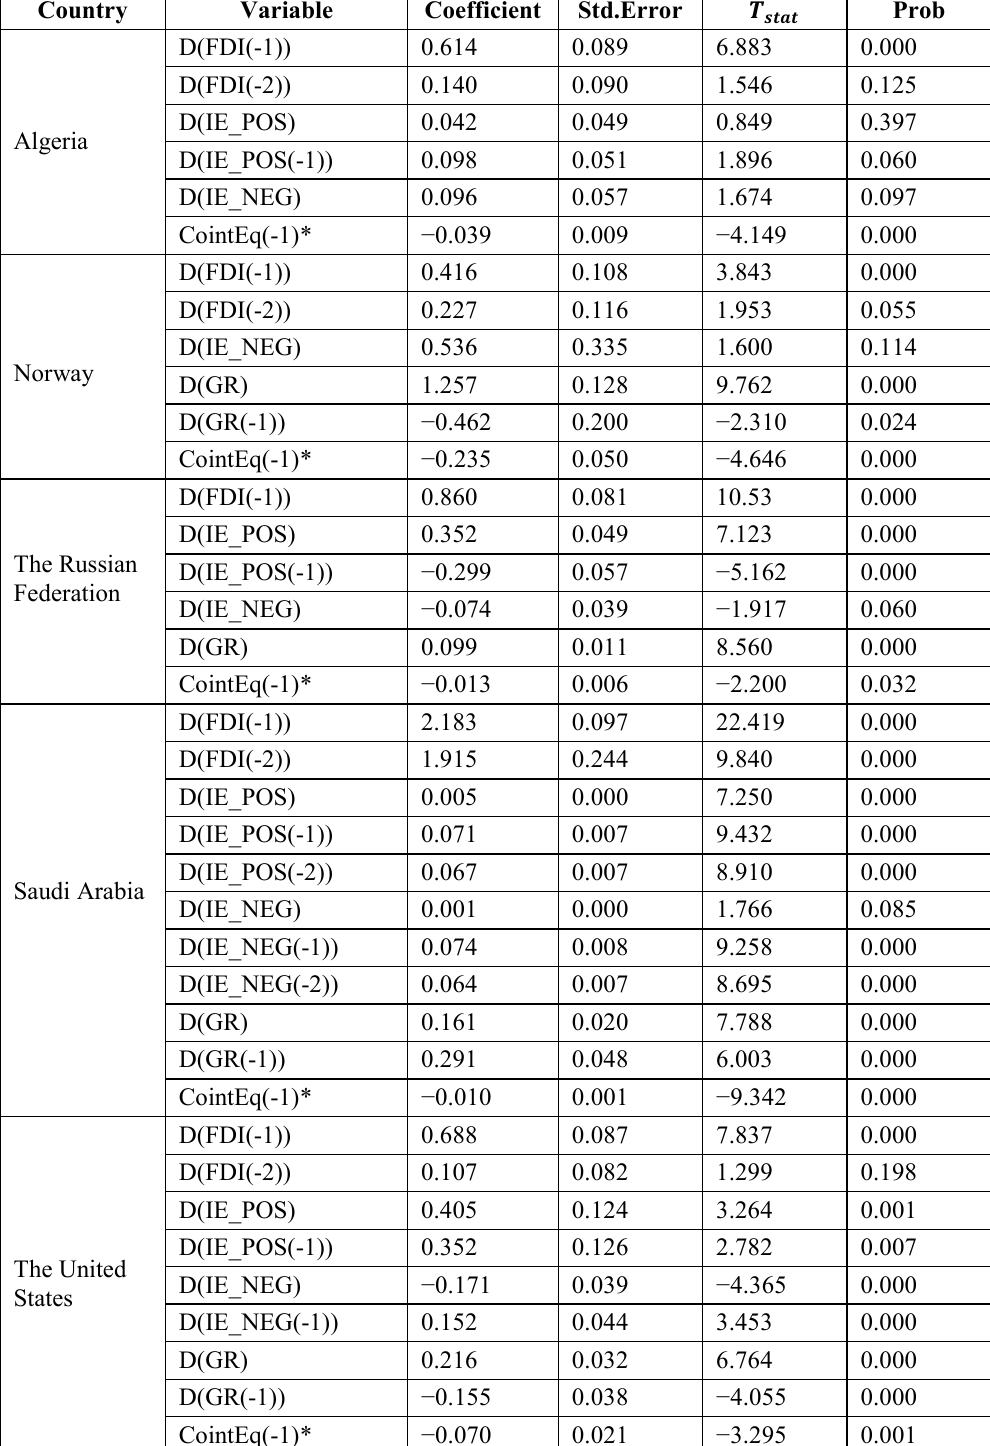
Table 8 . NARDL Models for Short-run